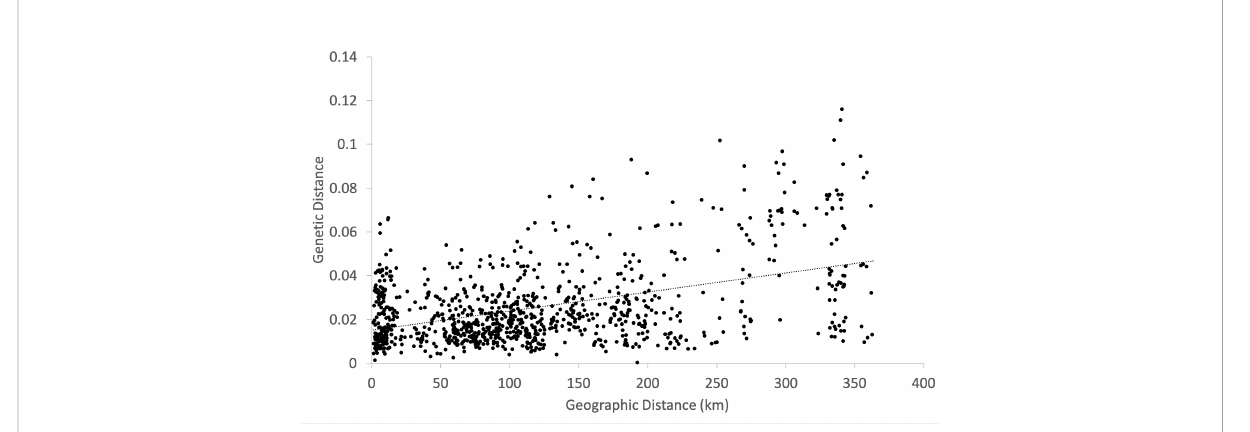
FIGURE 7 Isolation-by-distance between populations. Genetic distance matrix is based on F ST/ (1 - F ST ). Mantel test by 1,000 permutation detected positive correlation between genetic and geographic distances ( y = 0.015 + 9E-05 x , R 2 = 0.198, p = 0.001).